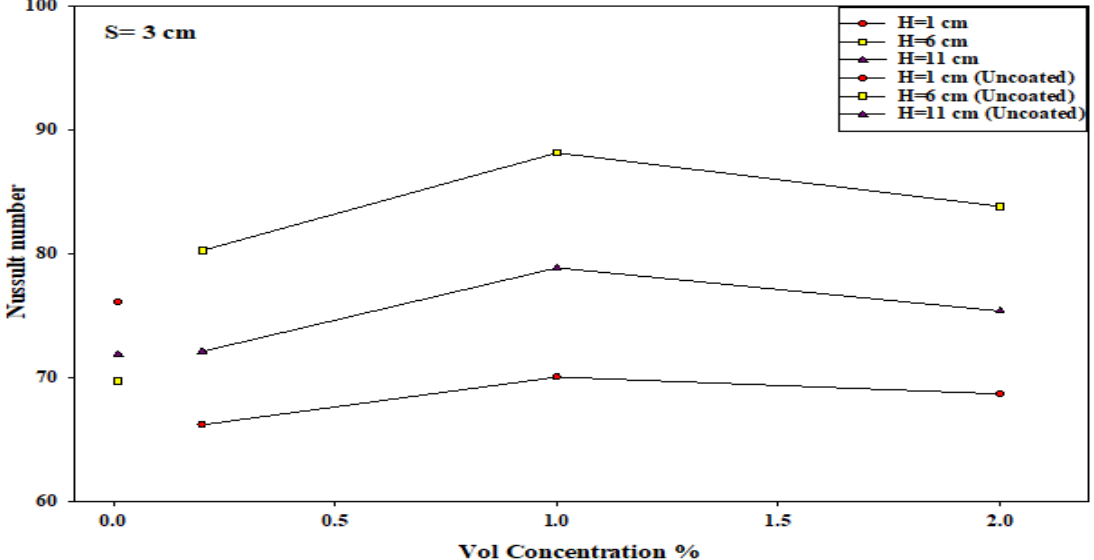
Figure 12. Effect of the nanosolution concentration and nozzle – plate distance when the nozzle – nozzle distance was 3 cm.